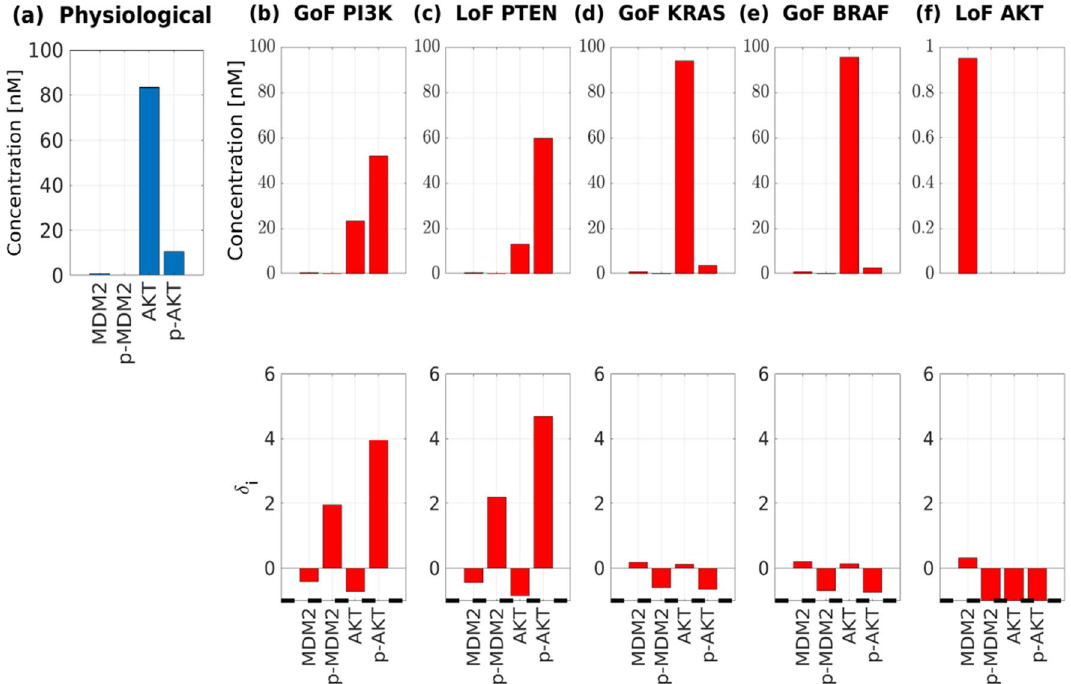
Figure 3. Effects of various single-gene mutations on the value of p53 concentration. ( a ) Value of the concentrations at the equilibrium of the physiological network of the proteins (directly) involved in the degradation of p53, namely MDM2, AKT, and their phosphorylated form p-MDM2 and p-AKT, respectively. ( b – f ) Effect on these concentrations of 5 mutations, namely GoF of PI3K, LoF of PTEN, GoF of KRAS, GoF of BRAF, and LoF of AKT. For each mutation in the upper panel, we show the values of the concentrations at the equilibrium of the mutated network. In the lower panel, the corresponding relative difference δ i is